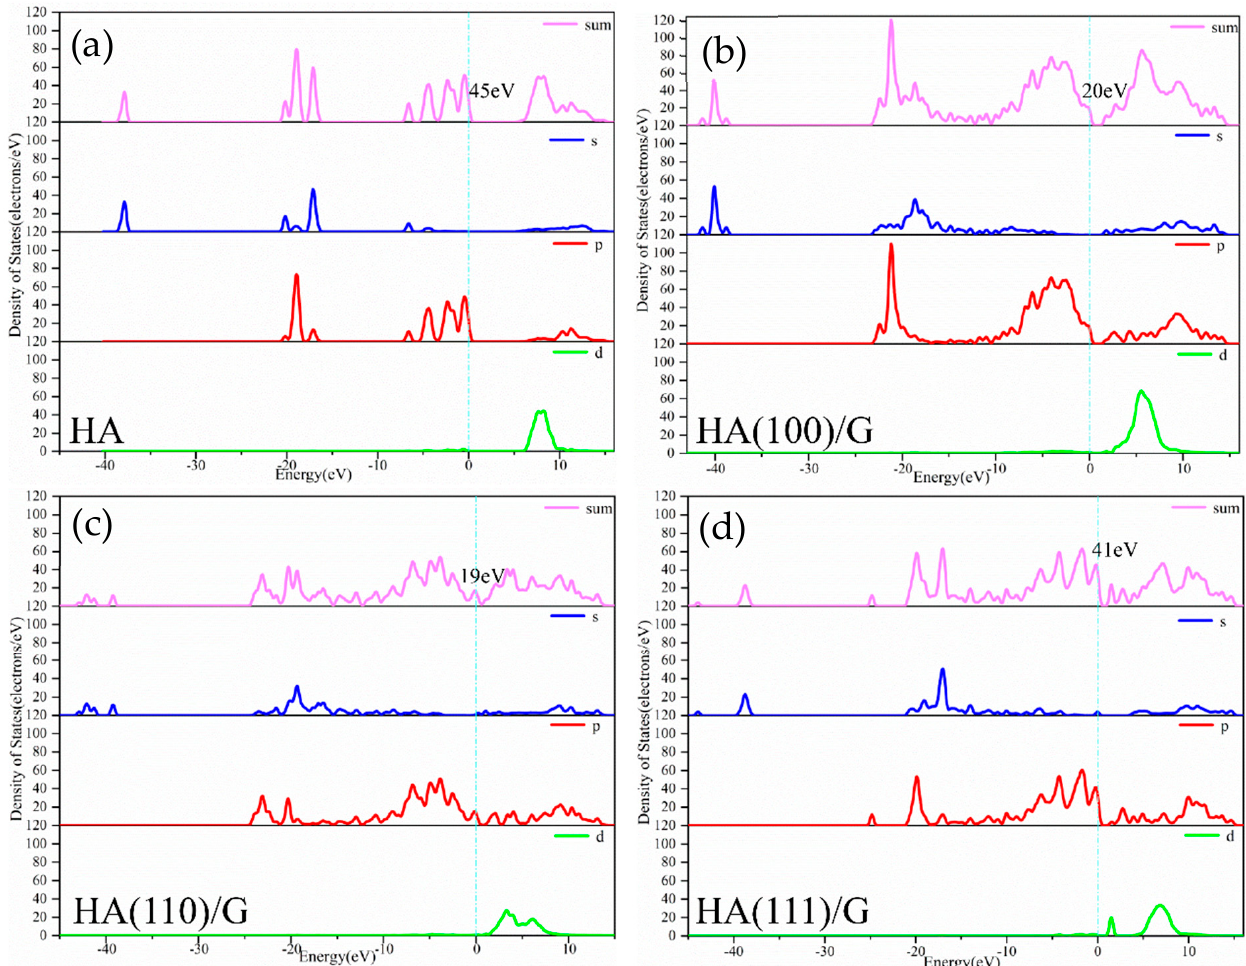
Figure 3. DOS diagrams of pure HA and G modified HA composite systems: ( a )HA, ( b )HA(100)/G, ( c )HA(110)/G, ( d )HA(111)/G After HA (100), (110) and (111) crystal planes were modified using GO, energy level